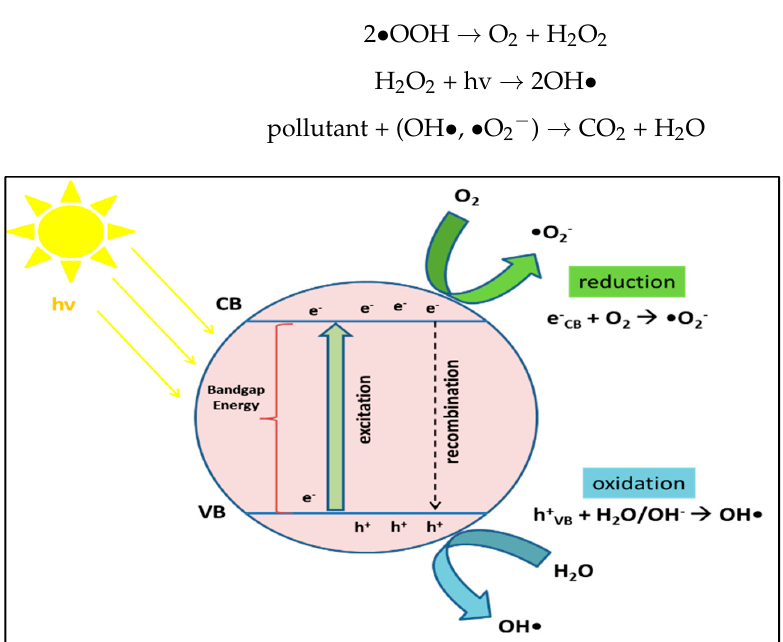
Figure 13. Schematic of photocatalytic mechanisms for organic pollutant